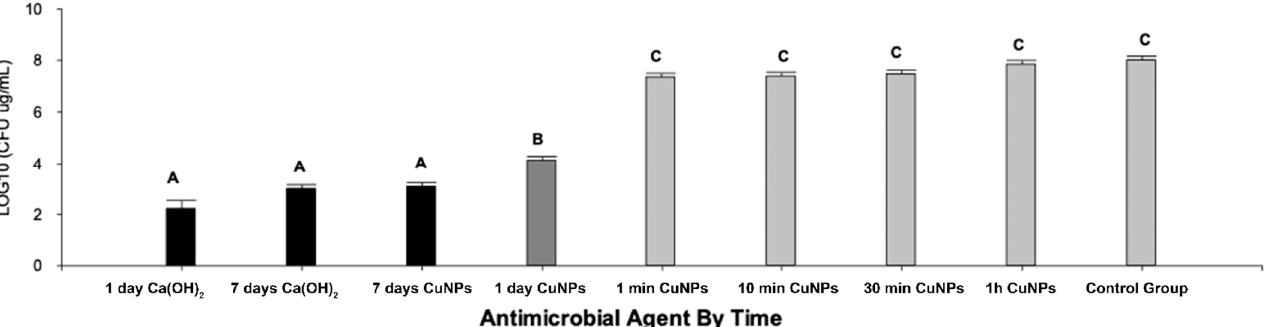
Figure 3. CFU count in log 10 per group and statistically significant differences between groups A, B, and C. ( p < 0.0001; ANOVA).